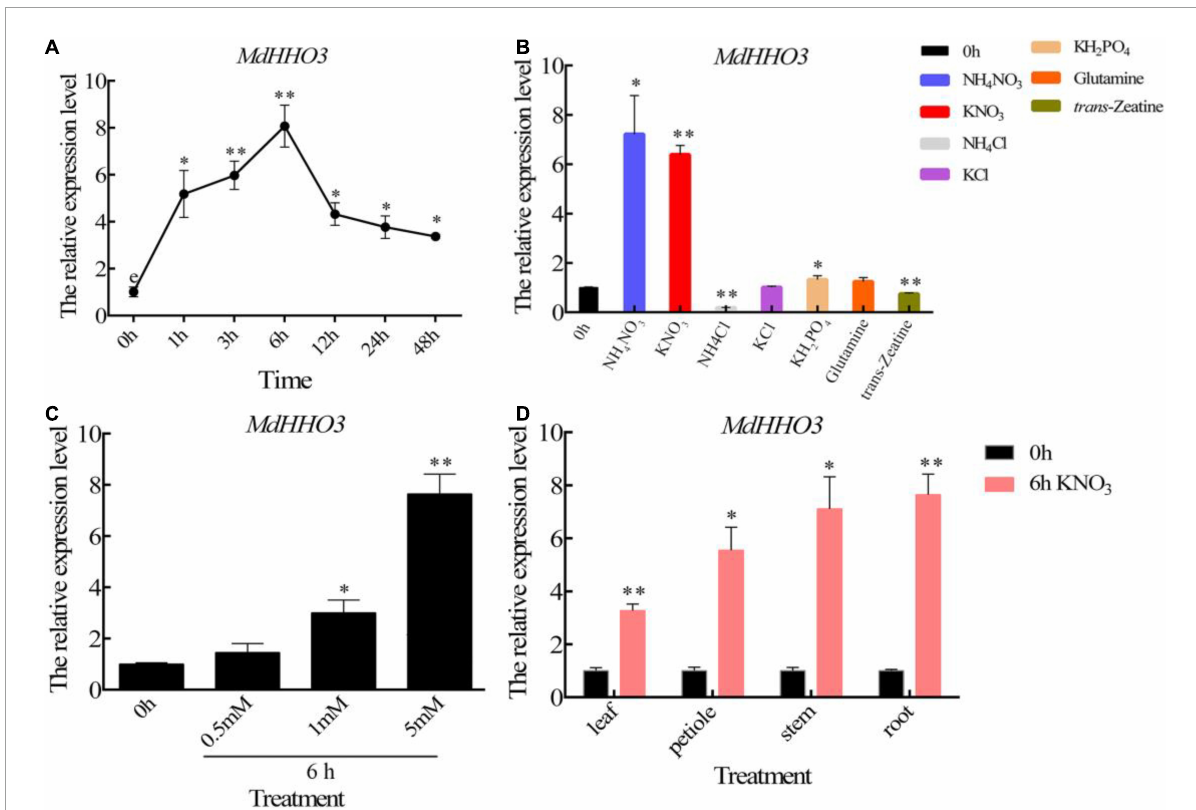
FIGURE3 Nitrate specifically induces the expression of MdHHO3 . (A) Time-dependent expression patterns of the MdHHO3 gene after the supply of 5 mM KNO 3 . (B) Expression pattern of the MdHHO3 gene after different N treatments. RNA was prepared from the roots of apple seedlings treated for 6 h with 5 mM NH 4 NO 3 , KNO 3 , NH 4 Cl, KCl, KH 2 PO 4 , and glutamine but not trans-zeatin (5 µ M). (C) Expression of the MdHHO3 gene induced by different nitrate concentrations. RNA was prepared from the roots of apple seedlings treated with 0, 0.5, 1, and 5 mM KNO 3 for 6 h. (D) Nitrate induced the expression of MdHHO3 in different plant tissues. Leaves, petioles, stems, and roots were collected from apple seedlings treated with 5 mM KNO 3 for 6 h. Malus × domestica “GL3” seedlings grown for 1 week with distilled water were used as controls. Three biological replicates of each sample were included, and the data are expressed as the means ± SDs ( n = 3). Significant differences were detected by a t -test: ∗ P < 0.05 and ∗∗ P <